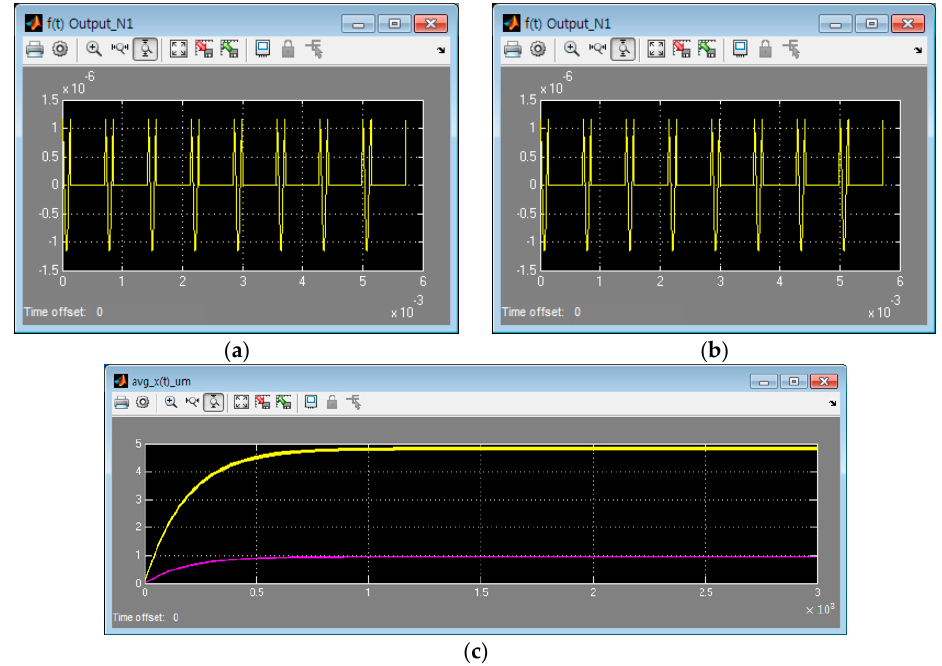
Figure 5. The displacement output by switched harmonic excitation [Matlab/Simulink]: ( a ) The control force input (N); ( b ) The displacement output ( t ď 40 ¨ 2 π ω s); ( c ) The displacement output ( t ď 3000 s) (yellow: continuous/pink: switched excitation).